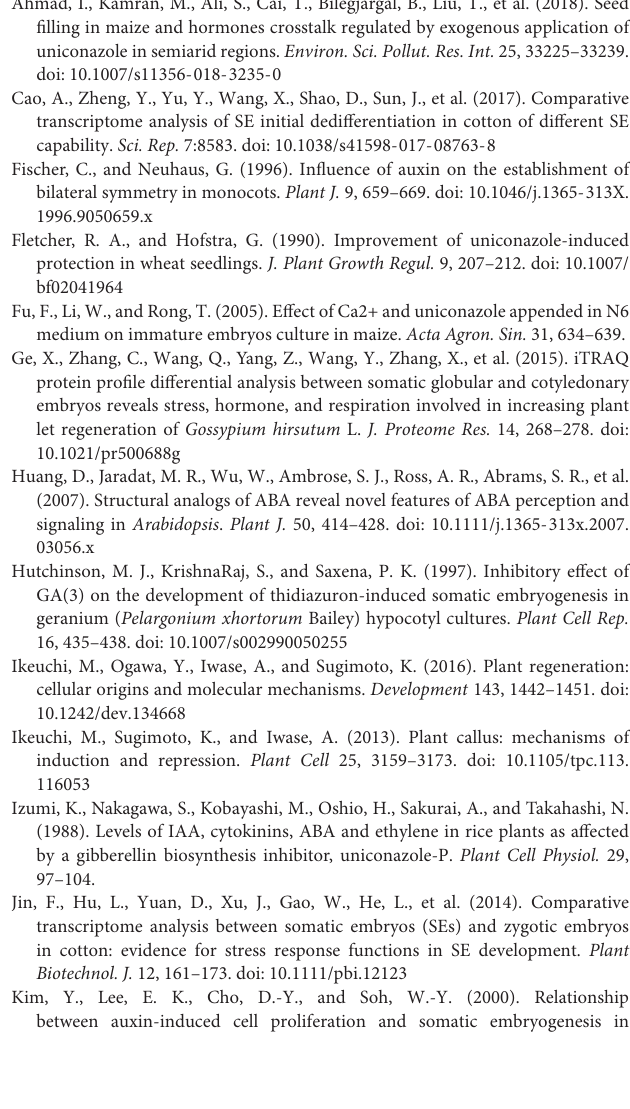
Supplementary Figure 3 | Phenotype of ECs after 60 days of cultivation on callus-induction medium (CK) and callus induction medium supplemented with uniconazole (Uni). Scale bar = 5 mm.